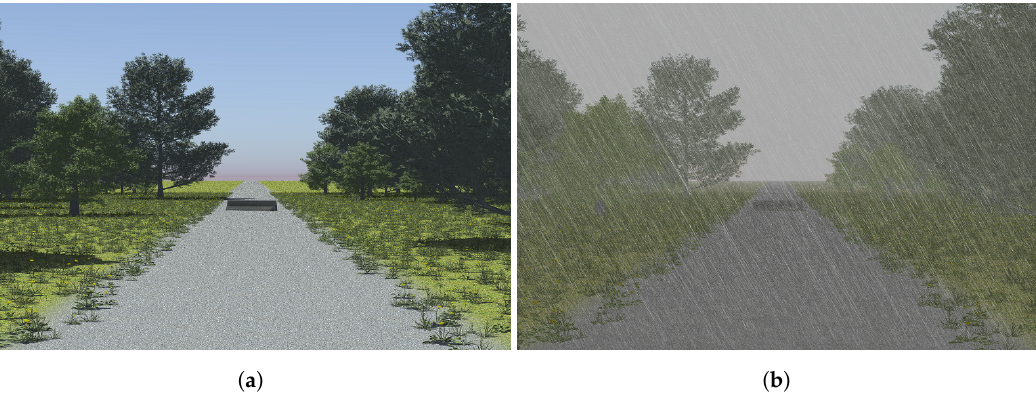
Figure 2. ( a ) The ODOA test scenario in clear weather, rendered by MAVS ( b ) When raining (R = 17